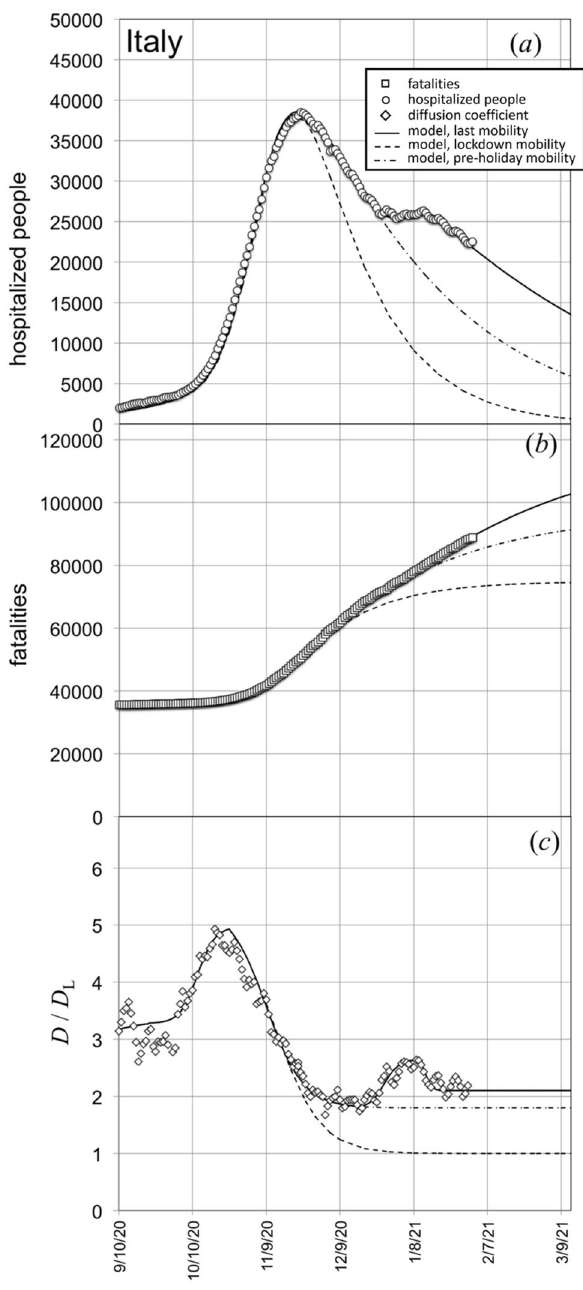
Figure 4. ( a ) Hospitalized people and ( b ) fatalities in Italy in the time range centered on the second wave of the outbreak and on holiday season 2020. ( c ) Evolution of the diffusion coefficient, in the same time range, normalized to the spring lockdown value D L . Continuous lines fit the present model to the data. Dashed lines correspond to the hypothesis of a general lockdown on October the 20th, 2020. Dot-dashed lines describe the situation we would have experienced if restriction mobility measures had maintained unchanged during holiday